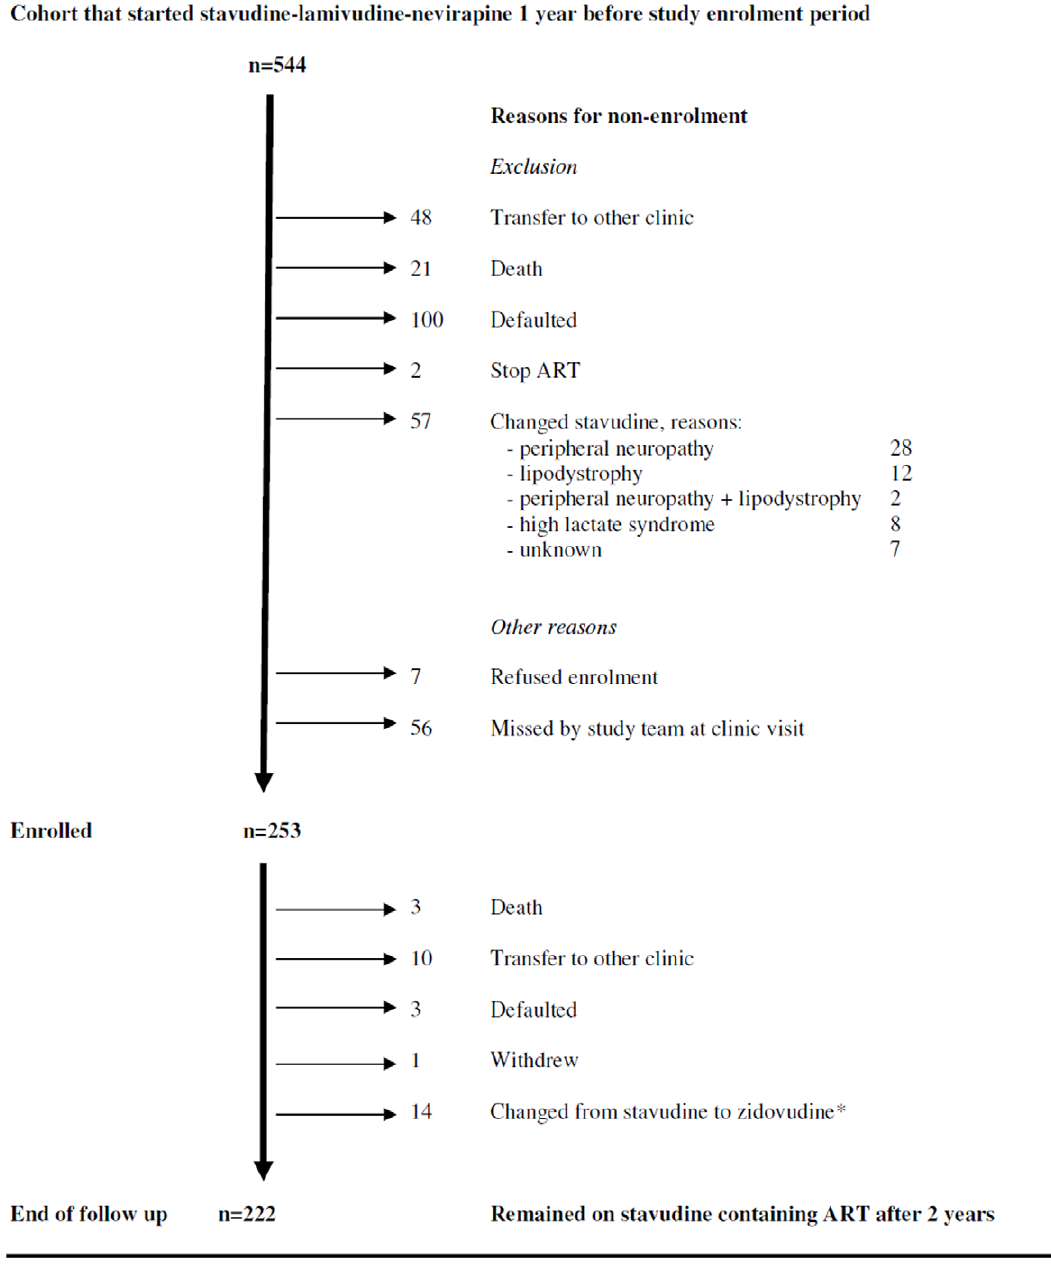
Figure 1. Study diagram.